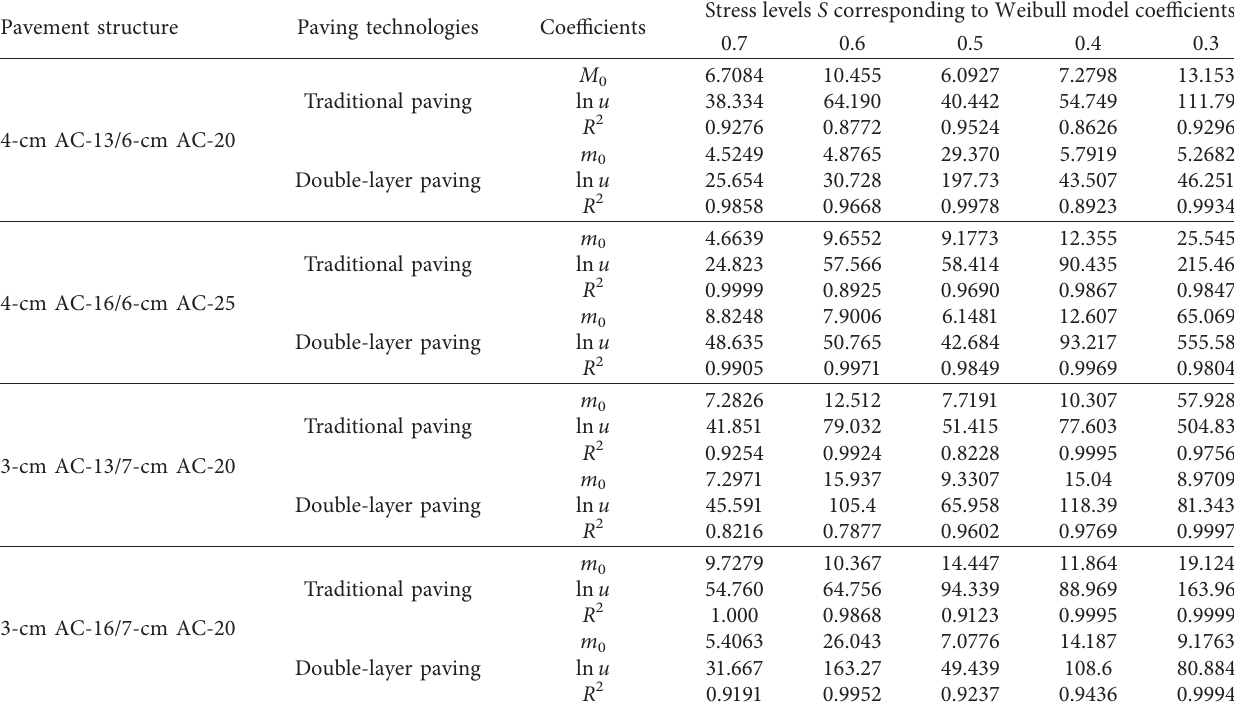
Table 6: Fatigue test results after examination by the Weibull distribution model.